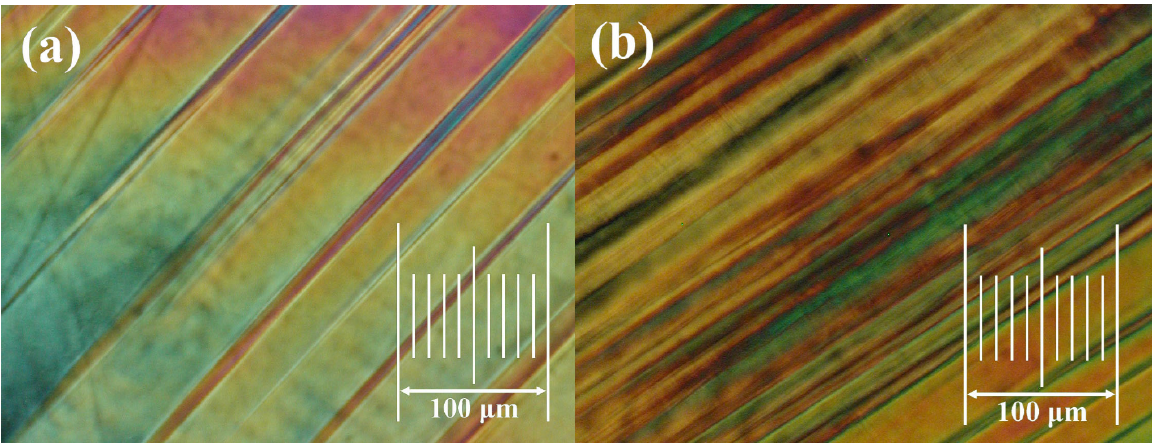
Figure 3. X-ray powder diffraction patterns of ( a ) as grown NBT-BT crystal and ( b ) BaTiO 3 crystal. Reprinted with permission from [24]. Copyright 2008 Elsevier.